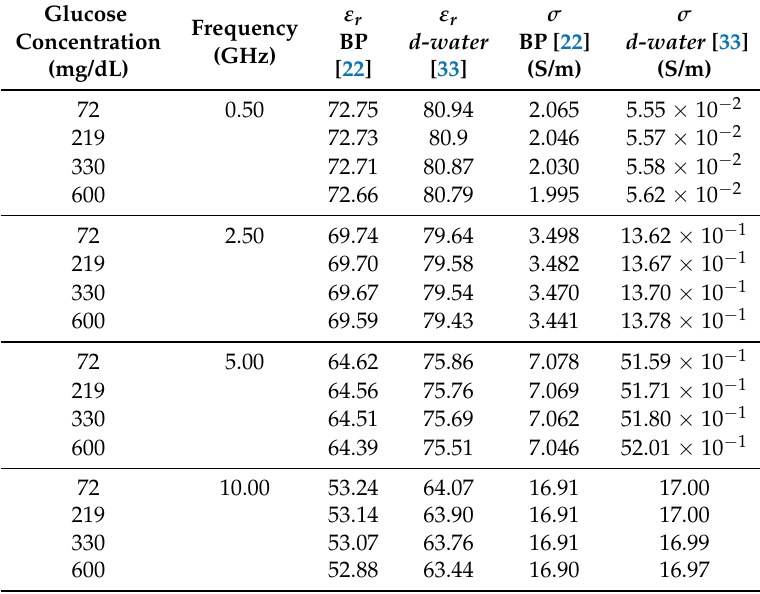
Table 3. Dielectric property change of blood plasma (BP) and water–glucose with respect to glucose concentration at 0.5, 2.5, 5.0 and 10 GHz based on the Cole–Cole and Debye parameter polynomials given in [22,33]. ( d-water —de-ionised water) Glucose ε